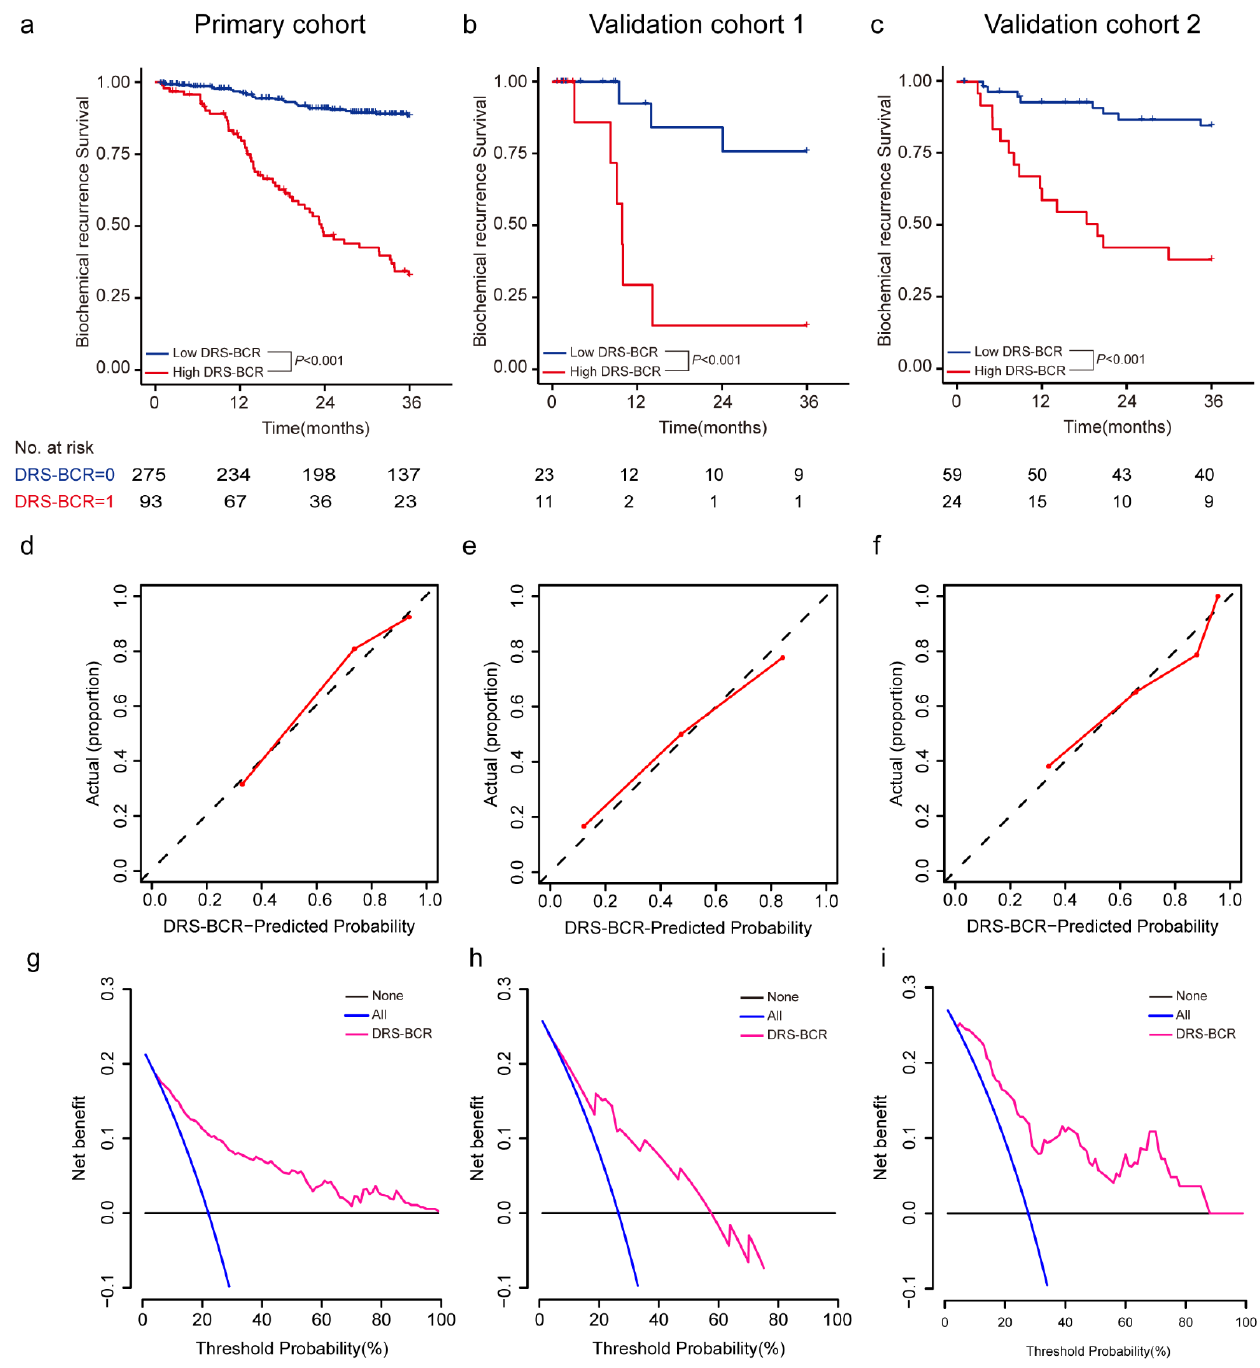
Figure 2. Performance of DRS-BCR for predicting 3-year BCR-free survival. ( a – c ) The Kaplan–Meier (K–M) curves of DRS-BCR-free survival for BCR-free survival within three years in the primary cohort, validation cohort 1, and validation cohort 2, respectively. The p values were calculated by log-rank test between subgroup with high-risk and low-risk, and significant discrimination was revealed by p values less than 0.05. ( d – f ) The calibration curves for 3-year BCR. ( g – i ) Clinical benefits by decision curve analysis for 3-year BCR. DRS: deep radiomic signature; BCR: biochemical recurrence.